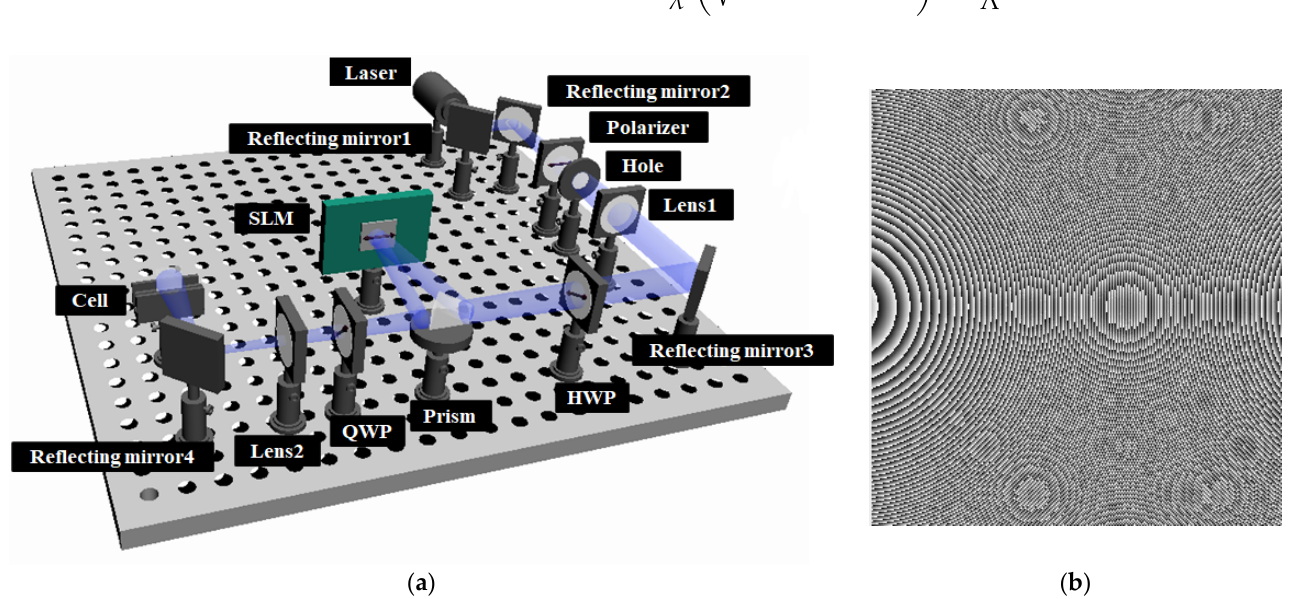
Figure 2. ( a ) Experimental setup of the single-step holographic exposure system used for a photo- sensitive azo-dye material SD1. ( b ) Simulation result of grayscale image loaded onto the SLM.